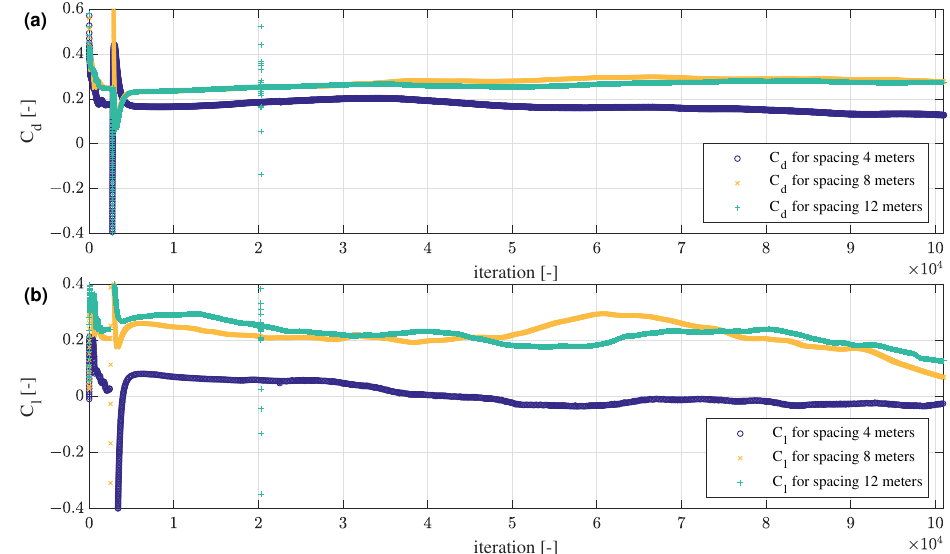
Figure 10. Comparison of the aerodynamic coefficients for heterogeneous columns consisting of three vehicles: van–truck–car. The graph shows data for vehicle number three: car. For the marker: dark blue “o”—the distance between the vehicles is 4 m, orange “ × ”—the distance between the vehicles is 8 m, teal “+”—the distance between the vehicles is 12 m. ( a ) Drag coefficient. ( b ) Lift